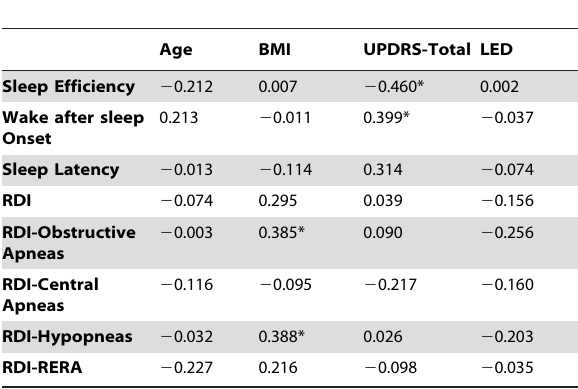
Table 3. Spearman correlation coefficients between clinical variables and sleep variables.